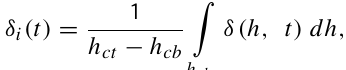
Fig. 4. Temporal variation of cloud asymmetry factor ( ξ) observed Figure 4 on three different nights in the year 1999 as typical